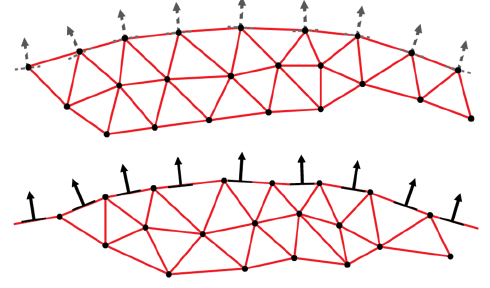
Figure 1: A TIN versus a Poisson DSM.